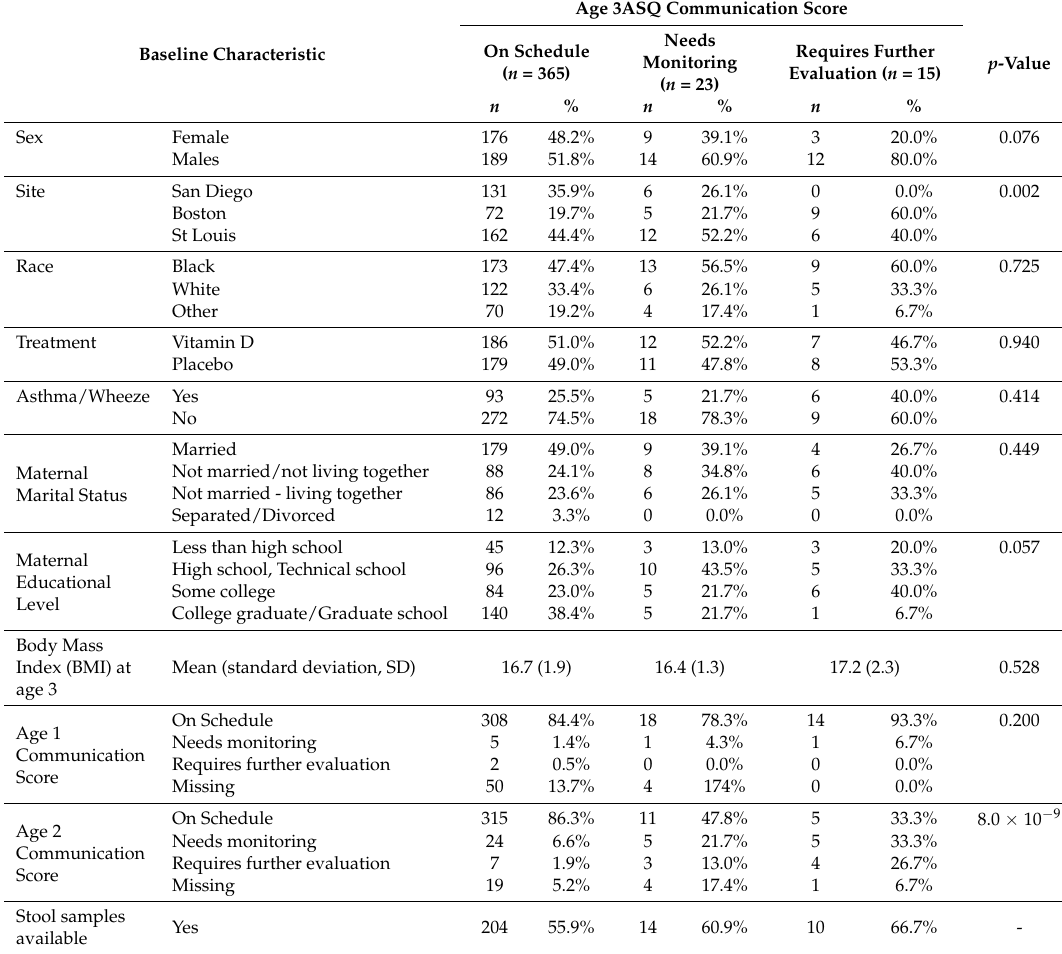
Table 1. Baseline characteristics of 403 children from the Vitamin D Antenatal Asthma Reduction Trial (VDAART) with plasma metabolomic profiling and an Ages and Stages Questionnaire (ASQ) score at age